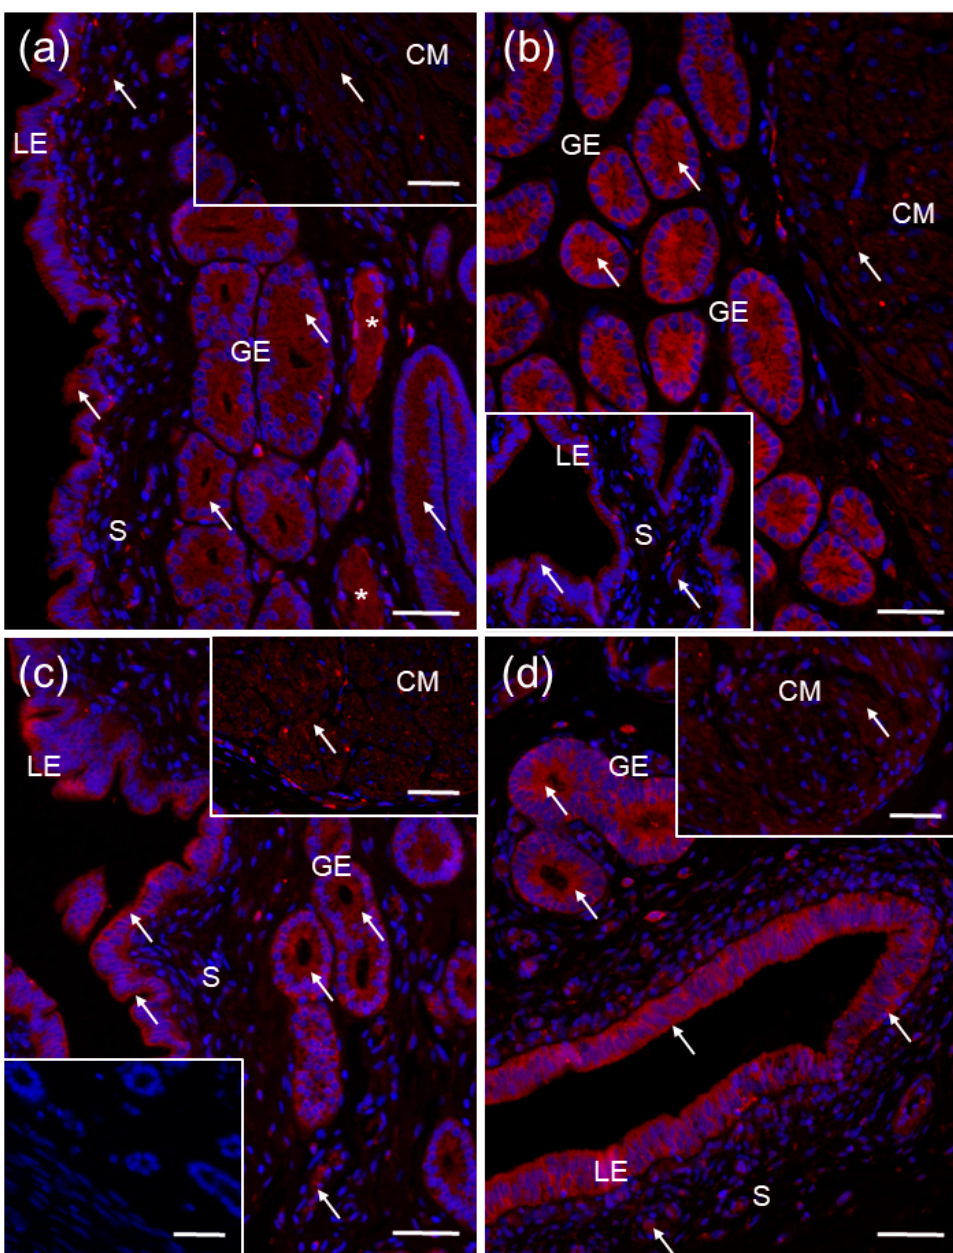
Figure 4. Representative micrographs of CYP27B1 immunofluorescent localization within porcine uterus on days 2–5 ( a ), 10–12 ( b ), 15–16 ( c ) and 18–20 ( d ) of the estrous cycle. Immunoreactive proteins were visualized using a Cy3 detection system (red). Nuclei were counterstained with DAPI (blue). Positive signal ( arrows ) was found in the cytoplasm of luminal (LE) and glandular (GE) epithelial cells of the endometrium, and myocytes within whole myometrial layer (only a circular myometrium (CM) is presented herein). Negative control ( c lower inset) was obtained by the replacement of primary antibody by non–immune rabbit IgG. S, stroma; asterisks (*), blood vessels. Bar = 50 µm.